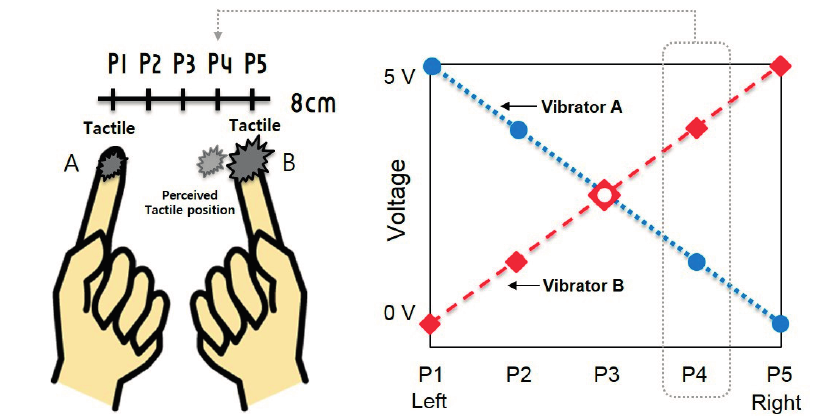
Figure 5. The amplitude rendering (as originally proposed by Alles [7]) for funneling to create phantom (or real) sensations at five different positions (P1–P5). For example, to generate a phantom sensation at P4, Vibrator A’s amplitude is set at 1.25 V and Vibrator B 3.75 V. An EEG cap was used to measure and document the brain activity. EEG data were attained at the 19 electrode sites (Fp1, Fp2, F7, F3, Fz, F4, F8, T3, C3, Cz, C4, T4, T5, P3, Pz, P4, T6, O1 and O2) on